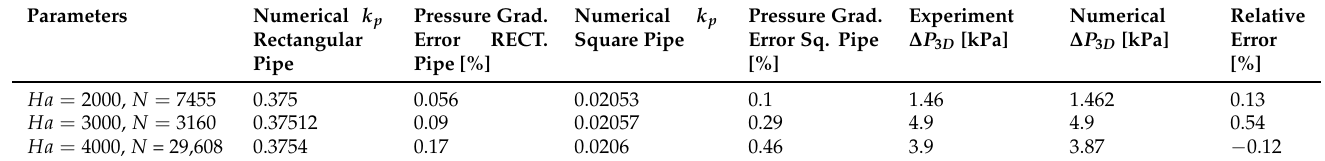
Figure 9. Total nondimensional pressure drop versus scaled axial length for Ha = 4000 and N = 29,608. Vertical dashed line points the sudden expansion. Table 7. 2D and 3D pressure losses errors, for different Ha and N